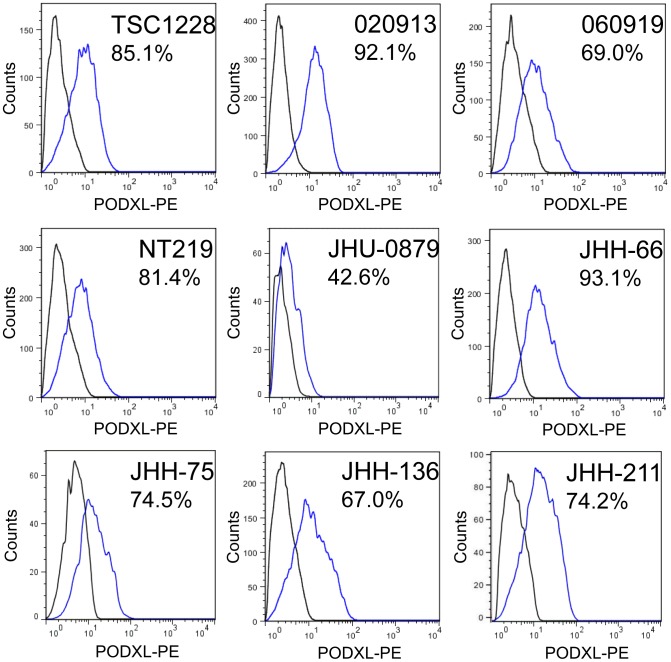
Analytical flow cytometry of GBM oncosphere lines for PODXL.All GBM oncosphere cell lines tested expressed PODXL, with the majority of the cell lines showing moderate expression of PODXL. The numbers represent the percent of cells positive for PODXL. The gate was set using 1.0% positive events from the PE-isotype population. The percent positive ranged from 42.6% to 93.1%.